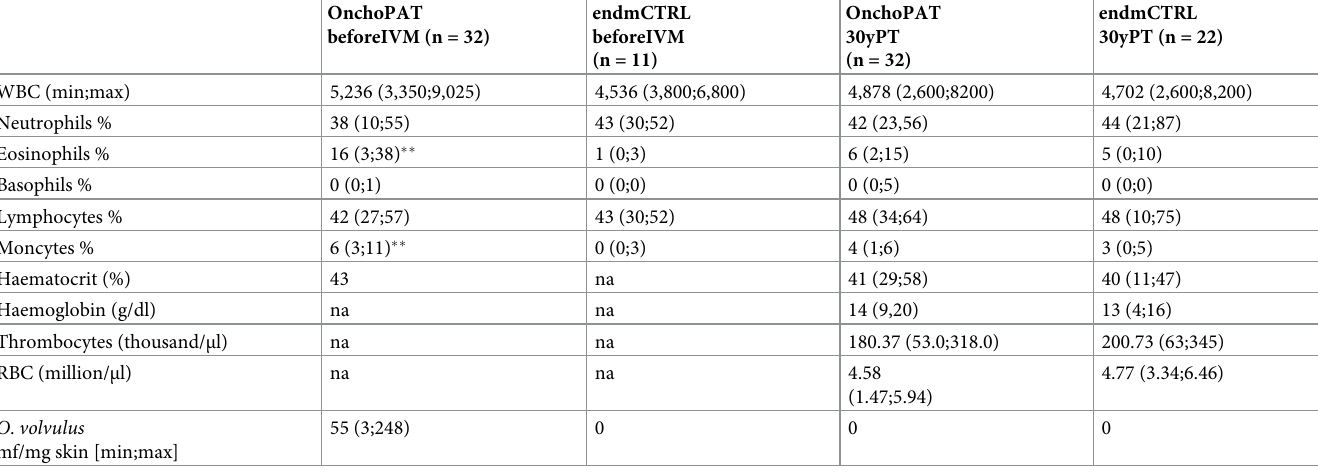
Table 1. The leukocyte blood cells, erythrocyte (RBC) and thrombocyte counts, haemoglobin concentration and haematocrit measured in peripheral blood samples from O . volvulus microfilariae positive onchocerciasis patients’ (OnchoPAT) patients and O . volvulus microfilariae-negative endemic control (endmCTRL) were surveyed in 1989 prior to initiation of community directed treatment intervention (CDTI) with ivermectin (beforeIVM) and at 30 years post annually repeated iver- mectin treatments (30yPT) in year